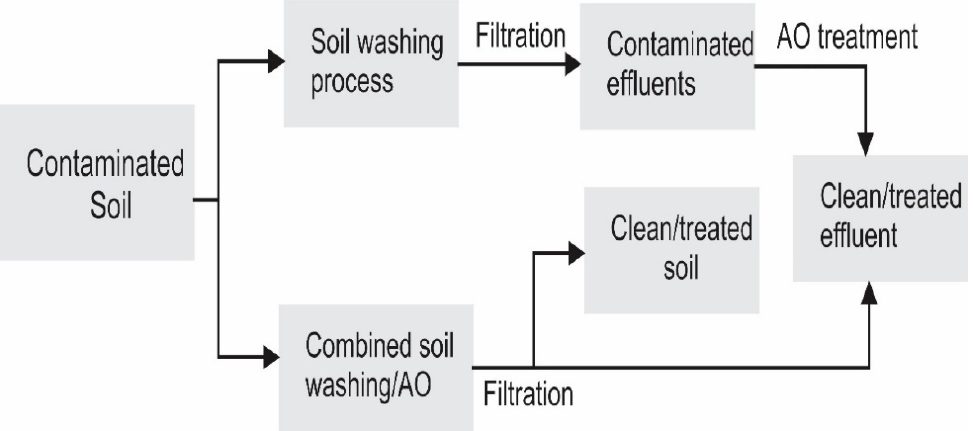
Figure 1. Schematic of different configurations of coupling soil washing (SW) with anodic oxidation (AO).